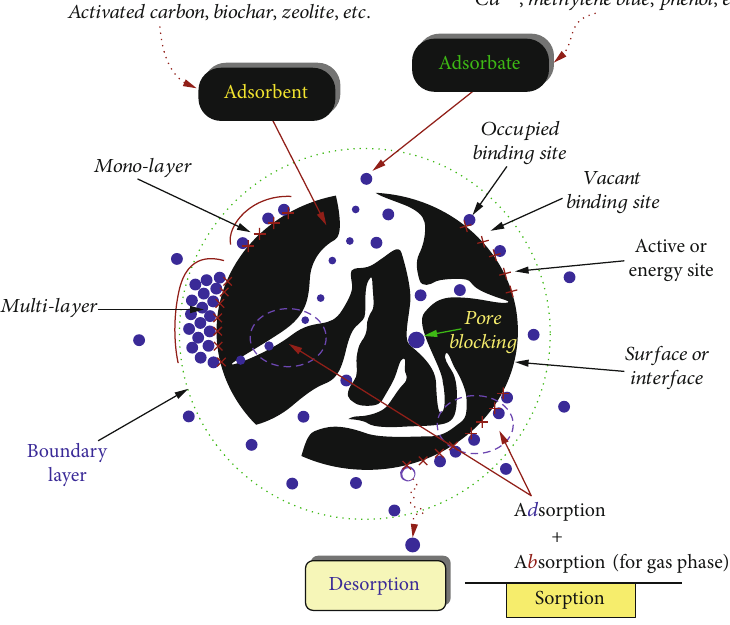
Figure 2: Basic terminologies used in adsorption process